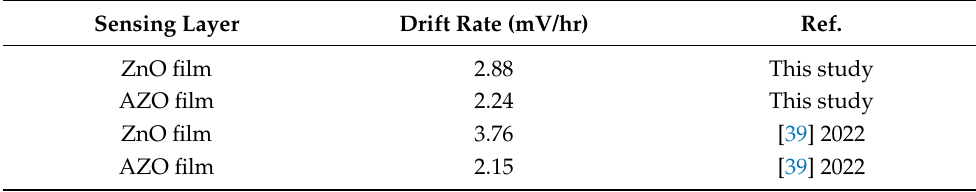
Table 5. The comparisons of the drift effect based on pH sensors with different structures.